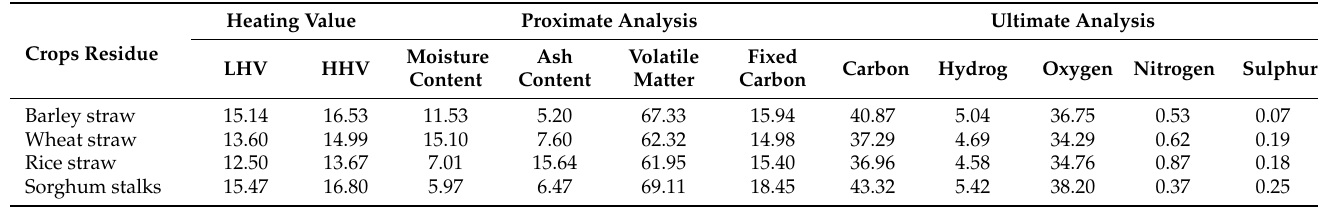
Table 5. Proximate and ultimate analysis of strategic seasonal-crop residues in Iraq [49].